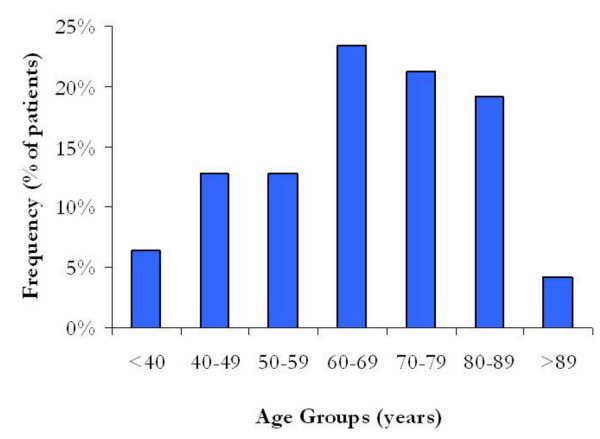
Frequency of male breast cancer cases by age. This illustrates the age distribution of male breast cancer patients in this study. This is expressed as a percentage of the total number of patients. Note the predilection for older men.